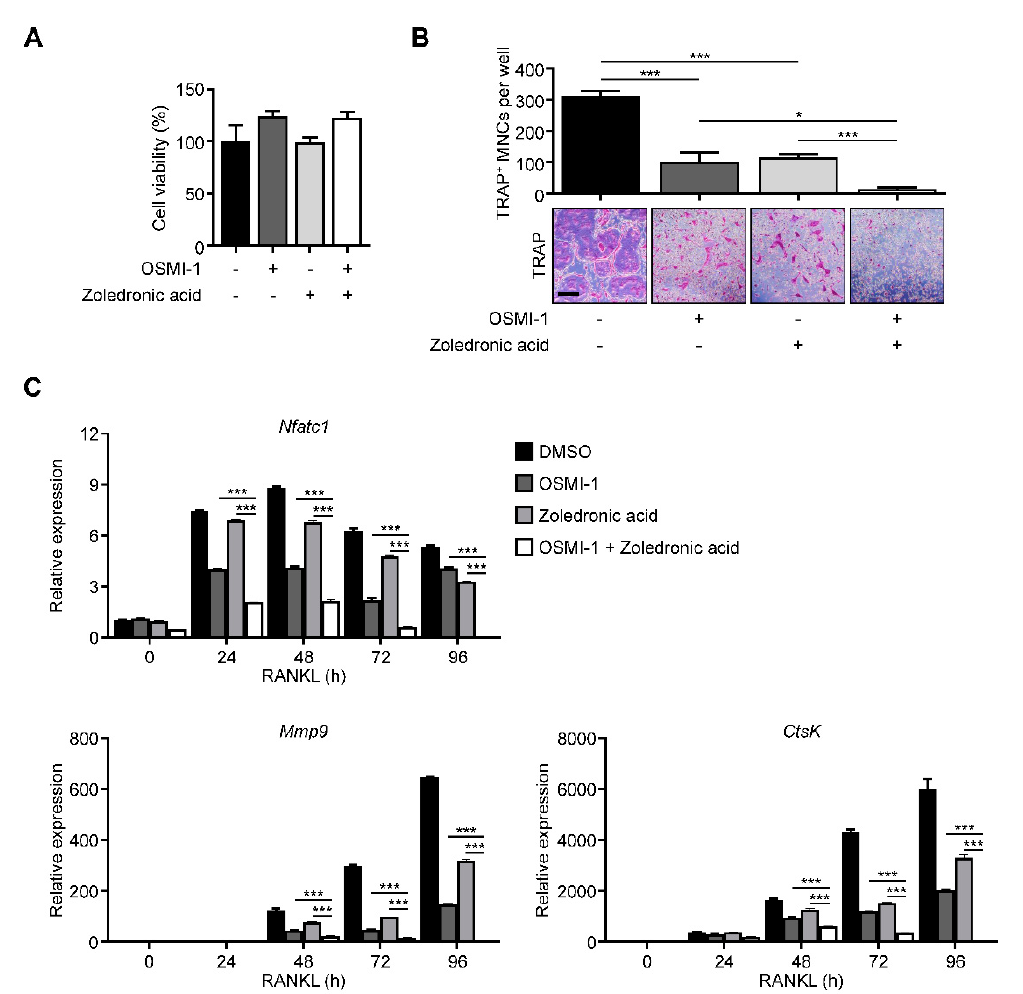
Figure 5. OSMI-1 enhances the effects of bone-targeted therapy on osteoclastogenesis. ( A ) Cell viability and ( B ) TRAP- specific mature osteoclasts with the drug combination of 5 µ M OSMI-1 and 1 µ M zoledronic acid during osteoclast differentiation, as analyzed by CCK-8 assay and TRAP staining. Scale bar, 200 µ m. ( C ) Relative mRNA expression levels of osteoclast markers were measured using RT-qPCR for the drug combination of 5 µ M OSMI-1 and 1 µ M zoledronic acid. Statistical data are presented as the means ± S.E.M. (* p < 0.05 and *** p < 0.001, as measured by Student’s t -test).